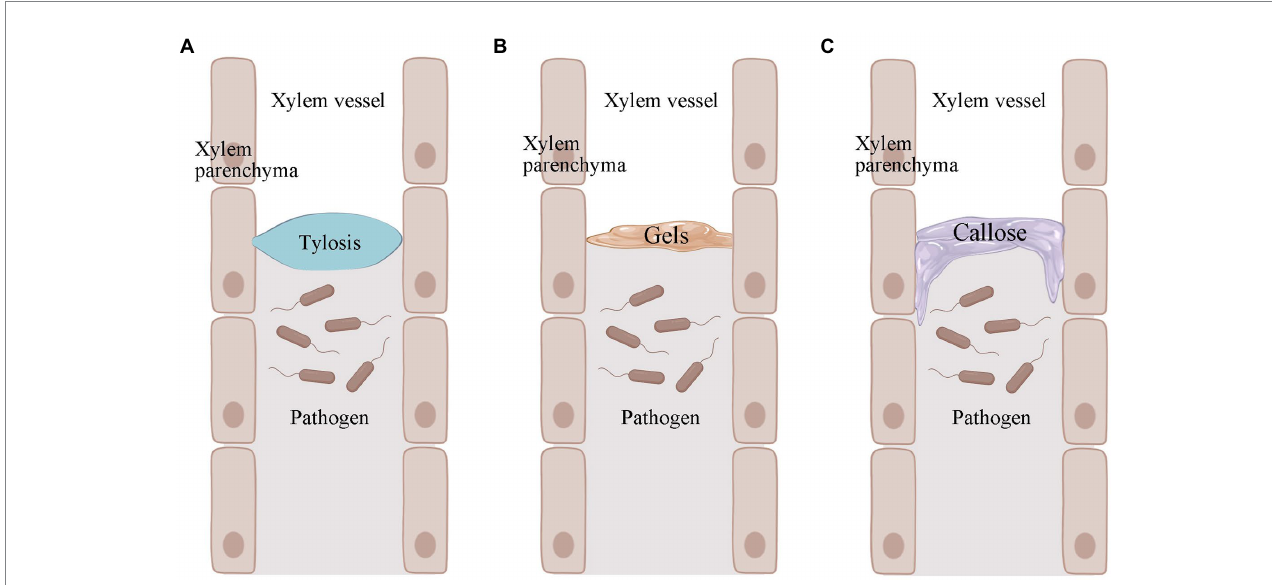
FIGURE 2 Pathogen-induced production of tyloses, gels, and callose in plants. ( A) Pathogen-induced plant production of tyloses. ( B) Pathogen-induced plant production of gels. ( C) Callose produced by pathogen-induced plants. Images were drawn through BioRender